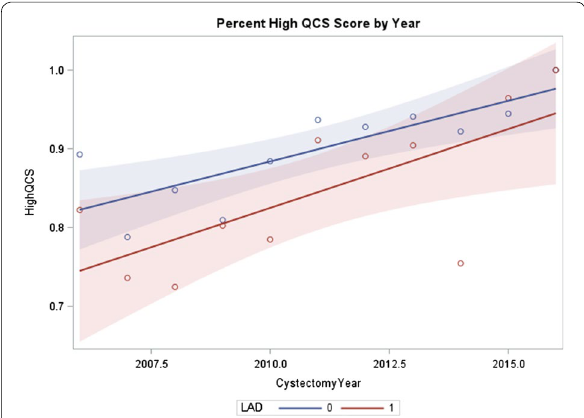
Fig. 2 Proportion of patients who received high QCS (star score of 3 or 4) over time (linear regression test: OCD, p